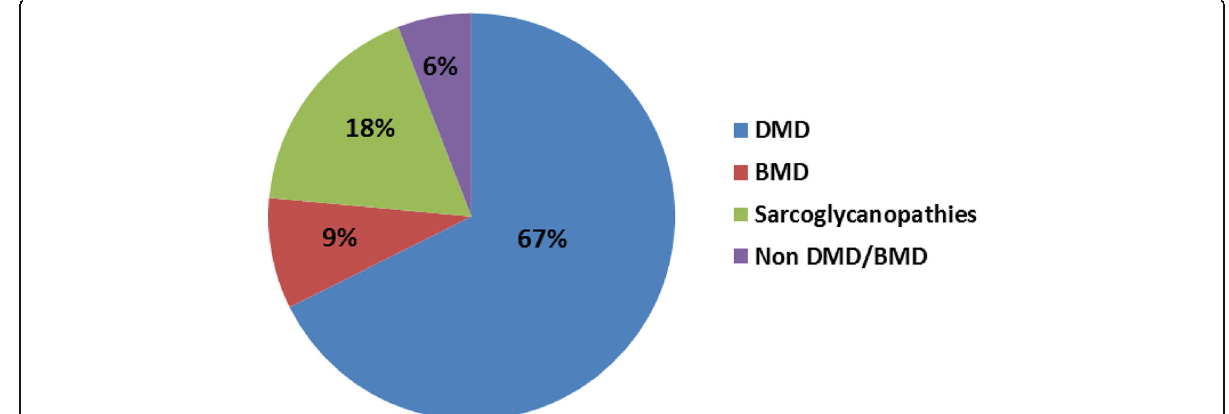
Fig. 4 MLPA negative cases analysed by immunostaining ( n = 34)